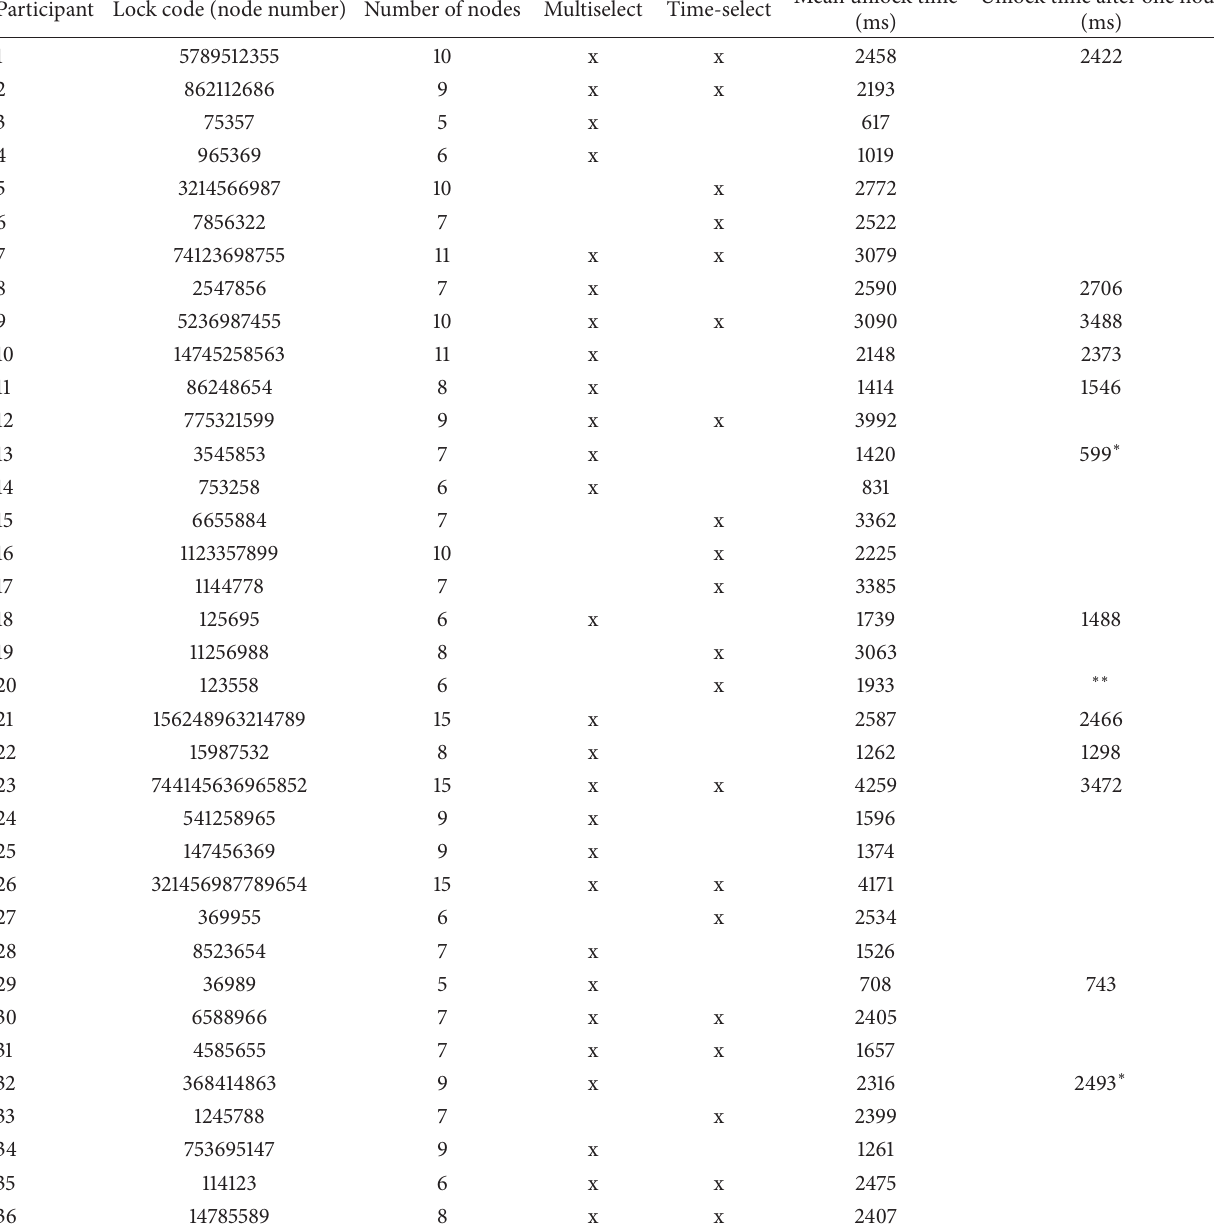
∗ At second attempt. ∗∗ Failed to unlock after 5